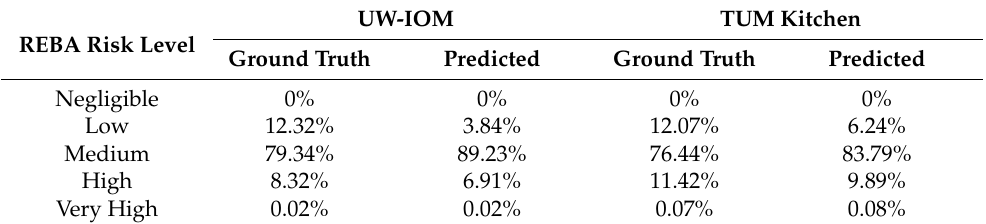
Table 6. Ground truth and predicted REBA risk level distribution on the UW-IOM and TUM Kitchen